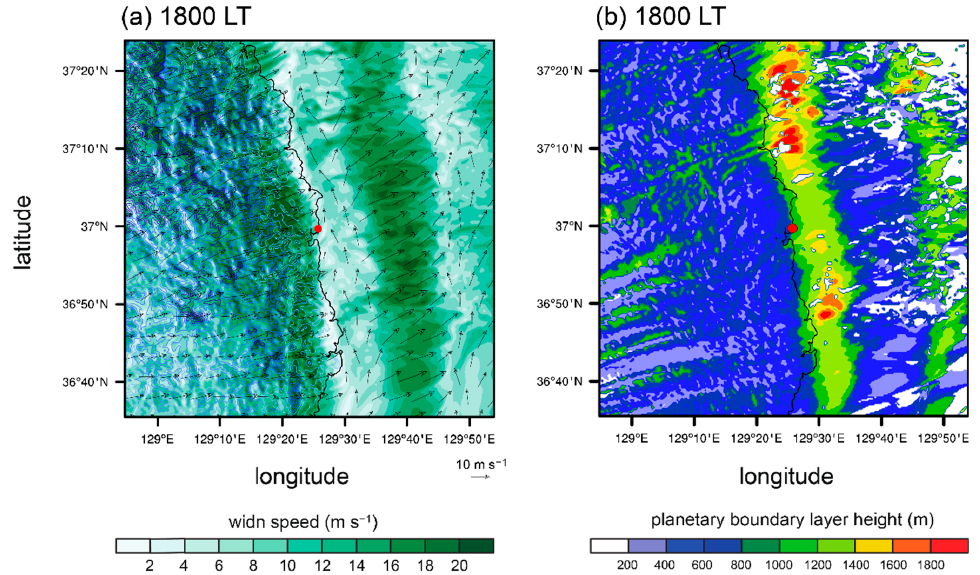
Figure 11. Simulated ( a ) 10-m wind speed and wind vector fields and ( b ) planetary boundary layer height field in A2 at 1800 LT. The red dot indicates the location of Uljin station.